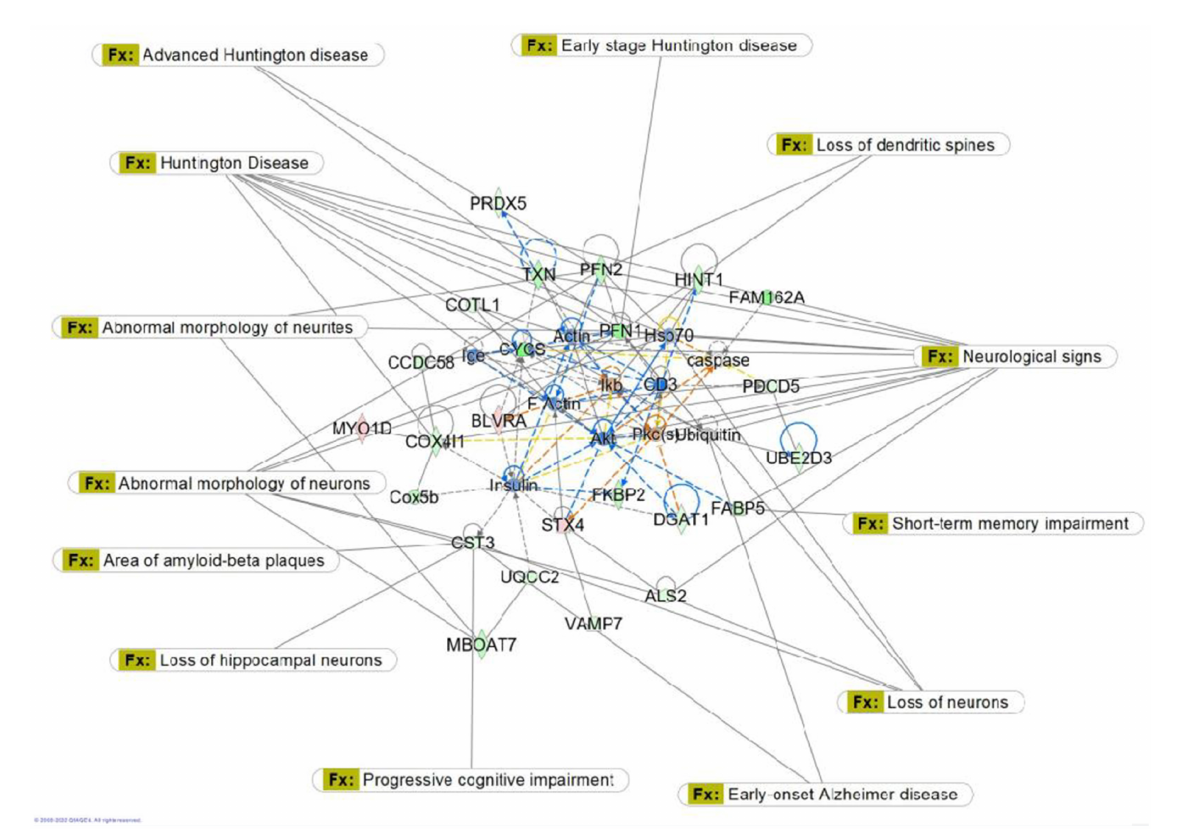
FIGURE9 Graphic representation of mouse hippocampus protein network 1, identified by Ingenuity Pathway Analysis (IPA) as being affected by sham irradiation compared to galactic cosmic rays (GCR) irradiation. Functions associated with the network include free radical-scavenging, cellular assembly and organization, and cellular function and maintenance. The network is overlayed with the disease and function tool to display the 15 key molecules involved with neurological